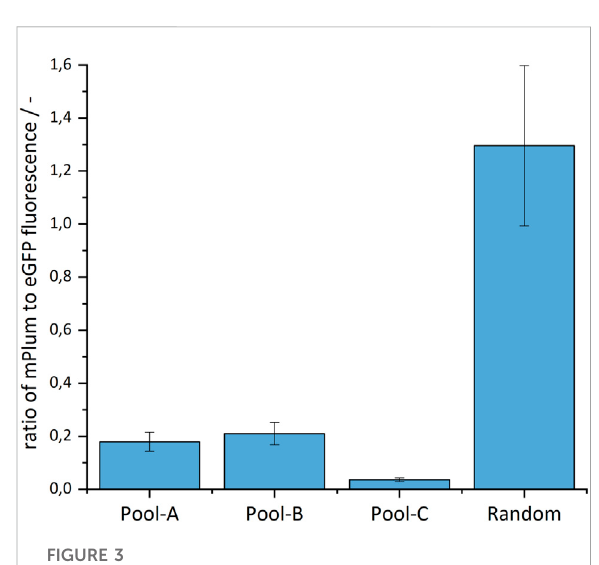
FIGURE 3 Ratio of the mPlum to eGFP fl uorescence signal in the site- speci fi cally and randomly integrated cell